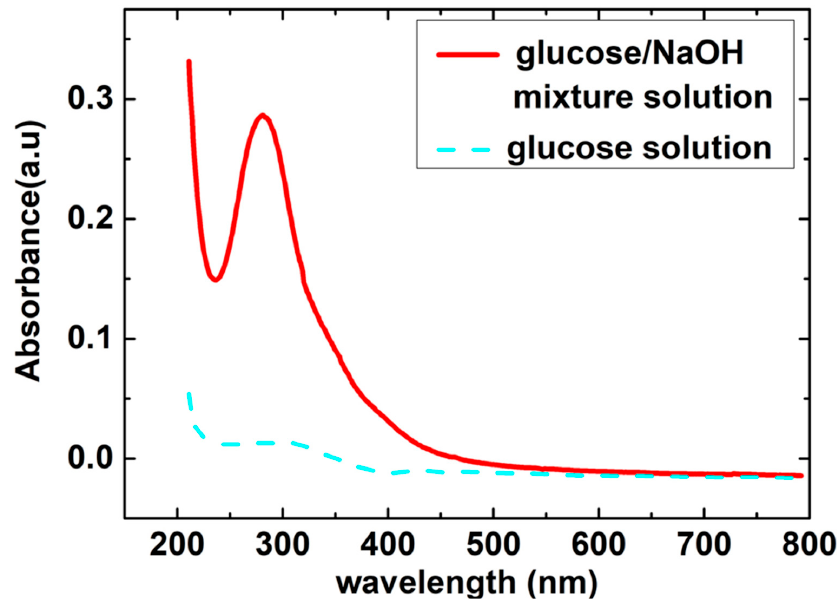
Figure 4. UV–vis spectra of the glucose/NaOH mixture solution (solid line) and glucose solution (dash line).